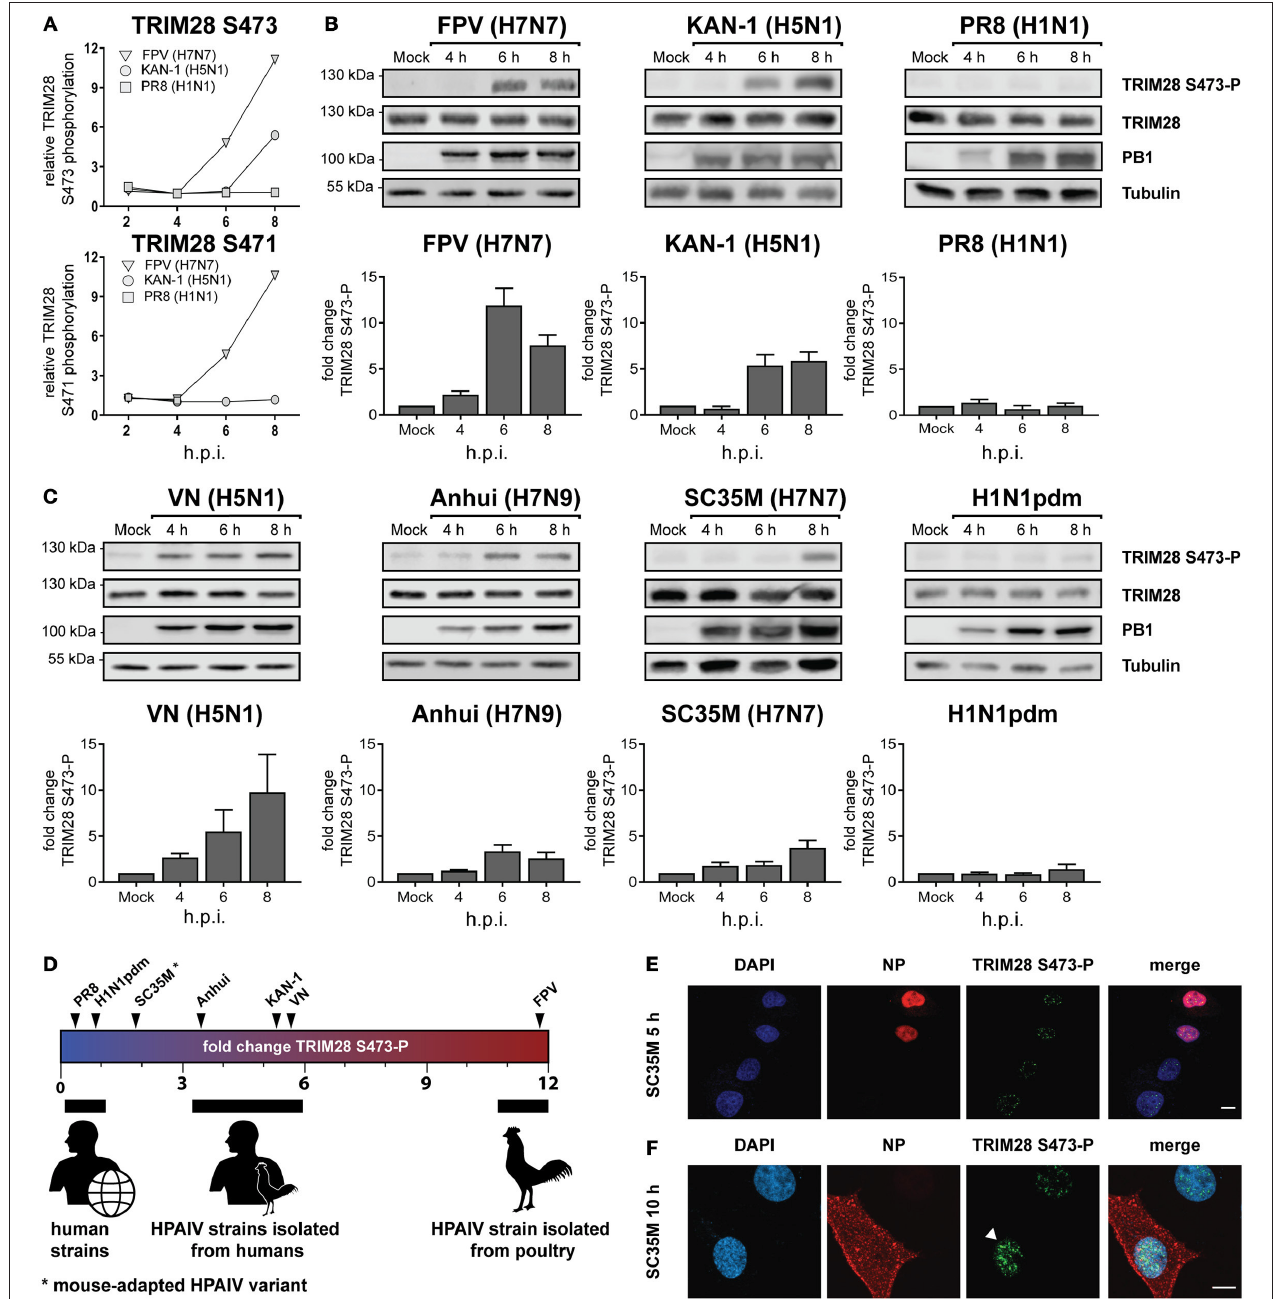
FIGURE 1 | Phosphorylation of TRIM28 during HPAIV infection. (A) SILAC-labeled human A549 cells were infected with FPV (H7N7), KAN-1 (H5N1), and PR8 (H1N1) for the indicated times at an MOI of 5. Phosphorylated peptides were enriched and analyzed by mass spectrometry. The relative phosphorylation of TRIM28 at serine 473 (S473) and serine 471 (S471) are depicted. Western blot of A549 cells infected with (B) FPV, KAN-1, PR8 and (C) VN (H5N1), Anhui (H7N9), SC35M (H7N7), H1N1pdm at an MOI of 5 for the indicated time points. Phosphorylation of TRIM28 S473 was detected using a phospho-specific antibody. Detection of total TRIM28 and tubulin served as loading controls. Densitometric quantifications of S473 phosphorylation were normalized to tubulin intensities and are depicted as mean fold change ( ± SEM). (D) Schematic representation of mean fold changes of TRIM28 S473 phosphorylation compared to non-infected cells at 6h p.i. A549 cells were infected with SC35M (E) at an MOI of 5 for 5h or (F) at an MOI of 0.5 for 10h. Nuclei were stained with DAPI. Viral nucleoprotein (NP) and TRIM28 S473 phosphorylation were stained using specific antibodies. Cells were analyzed by confocal laser scanning microscopy.